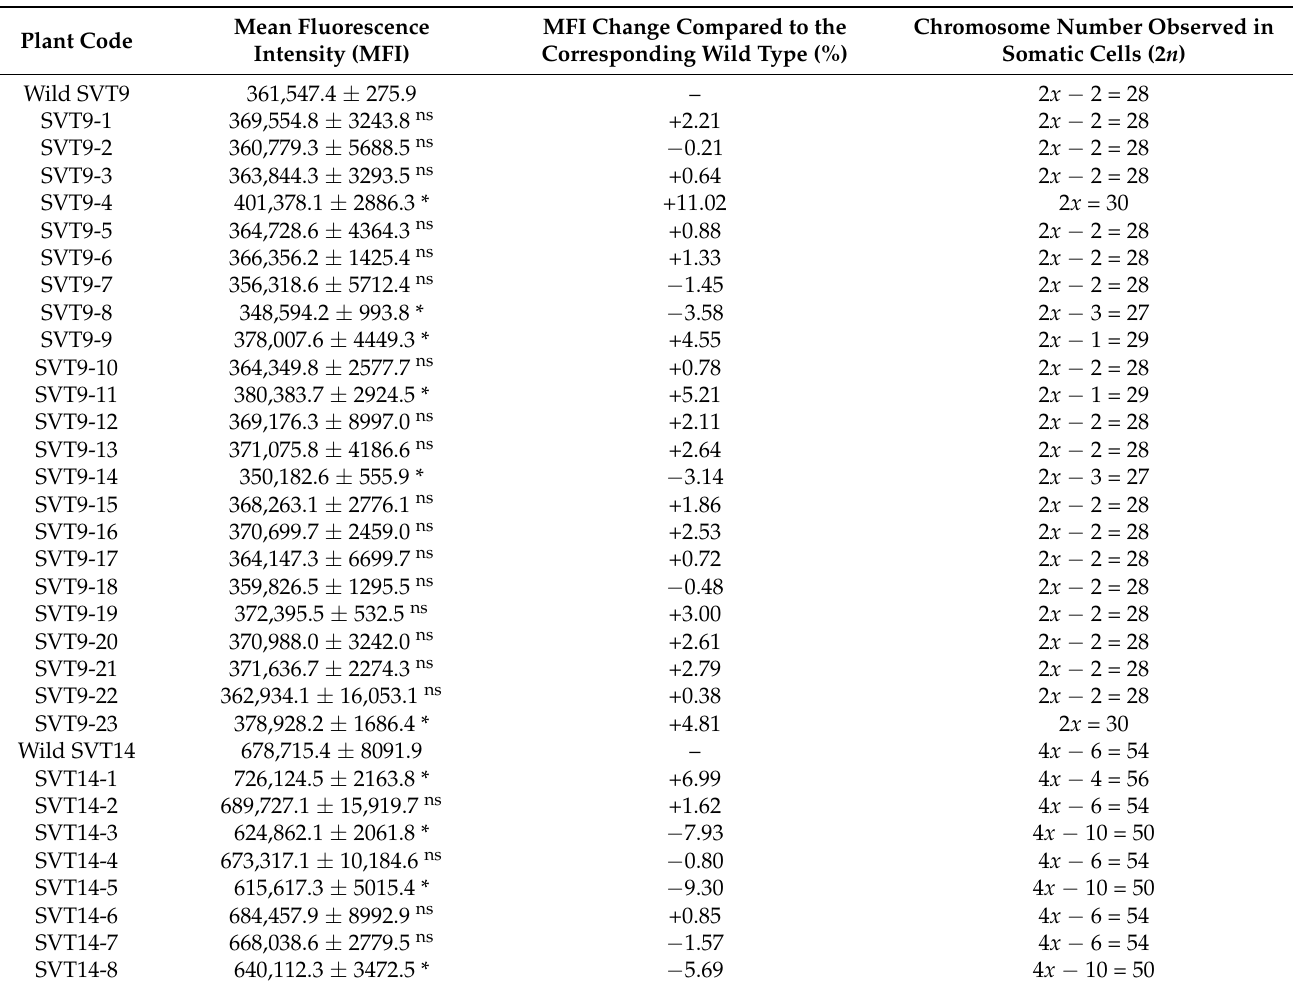
Table 4. Relative DNA content and chromosome count of the aneuploid caladium plants and their